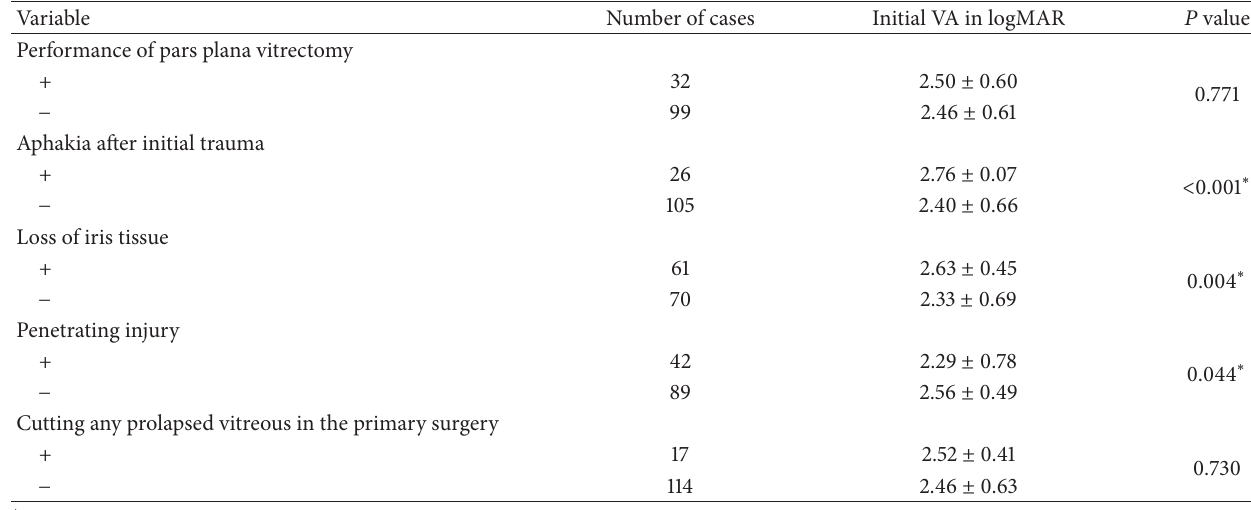
Table 5: The comparisons of the initial visual acuities among cases with and without the significant independent variables after the backward stepwise elimination.